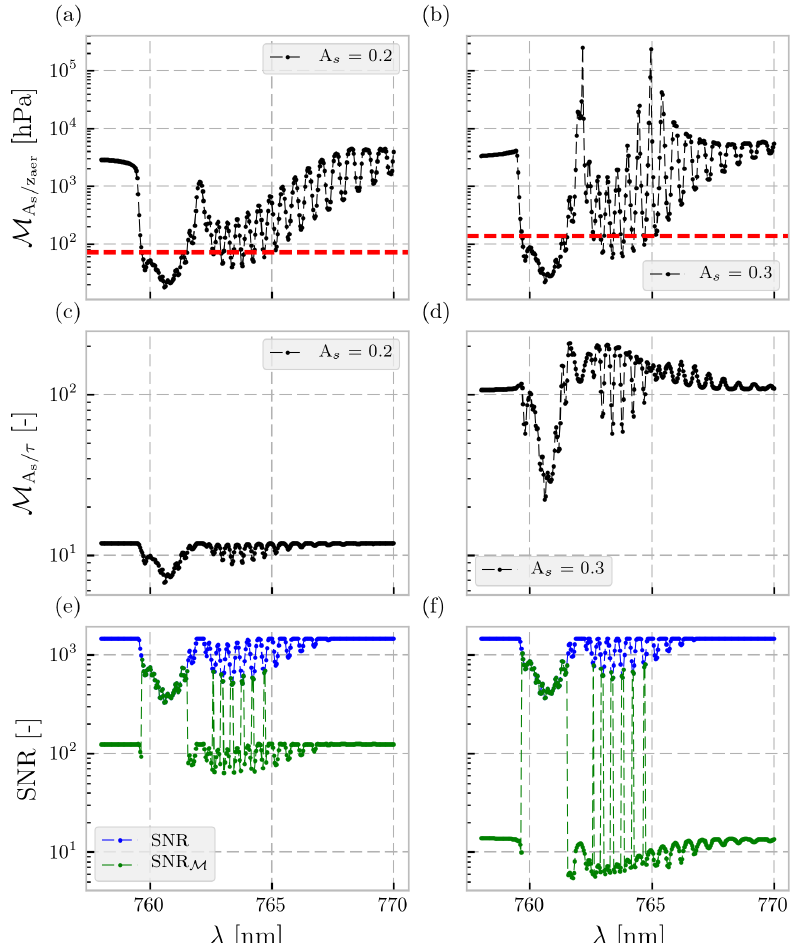
Figure 1. (a, b) Modifying vector M A as a function of wavelength λ . The solar zenith angle is 45 ◦ , the viewing zenith angle is 20 ◦ s /z aer and the relative azimuth angle is 0 ◦ . The aerosol optical thickness ( τ ) is 0.5 at 760nm over a surface with an albedo of 0.2 (a, c, e) and 0.3 (b, d, f) at 760nm. The height of the aerosol layer is 900hPa with a pressure thickness of 200hPa. The aerosol single-scattering albedo is 0.95 and the aerosol scattering is described by a Henyey–Greenstein phase function with an asymmetry factor of 0.7. The red dashed line represents the modification threshold value T , which has been set at the 20th percentile of M A in this example. (c, d) Modifying s /z aer function M A , Eq. (8) as a function of wavelength. (e, f) The blue line represents the unscaled SNR, whereas the green line represents the s /τ modified SNR according to Eq.